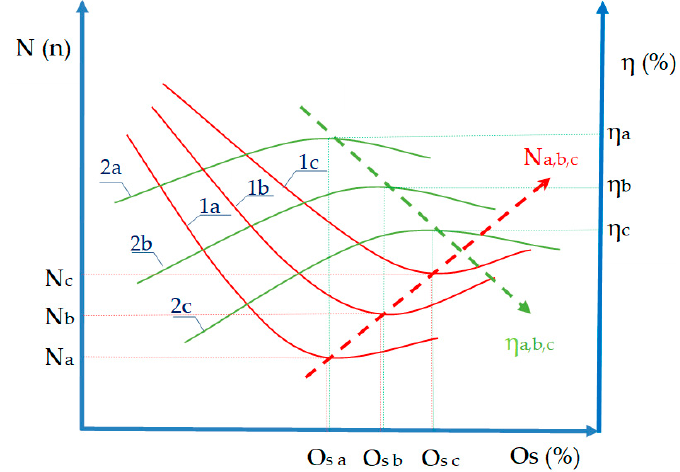
Figure 2. Size pick-up (Os / %), number of breaks on the loom in unit of time (N / n), loom e ffi ciency rate ( η / %); a,b,c—three yarn samples, η a,b,c—maximum loom e ffi ciency rate (%), Na,b,c—minimum number of yarn breaks on the loom (n), Osa,b,c—optimal size pick-up (%), 1a,b,c—curves indicating the relation between the number of breaks and size pick-up, 2a,b,c—curves indicating the relation between the machine e ffi ciency and size pick-up, Na,b,c—course of increasing optimal size pick-up in the deteriorating yarn, η a,b,c—course of reducing the loom e ffi ciency rate in the deteriorating